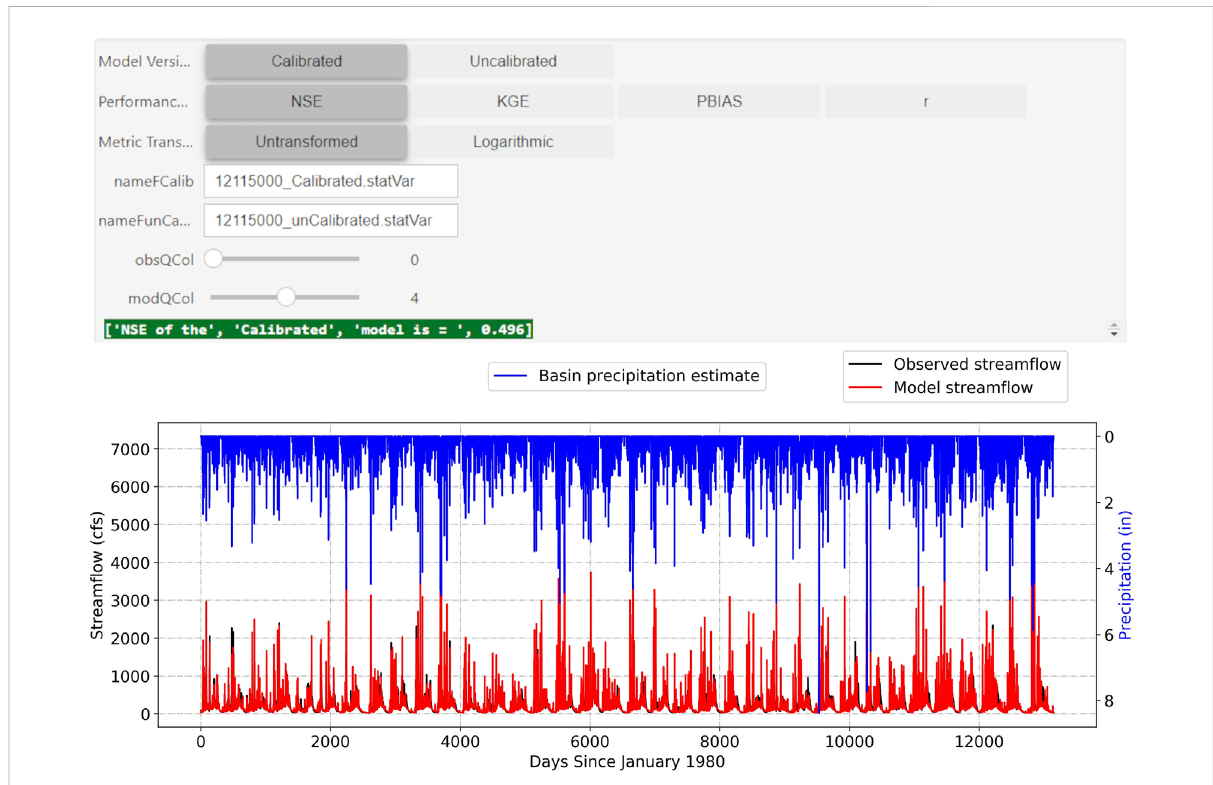
FIGURE 4 Screenshot of HydroBench interactive window showing predictive performance metrics and the corresponding hydrograph for NHM-PRMS simulations of the Cedar River watershed daily stream fl ow, 1980 – 2016, compared to observations (USGS stream gage, 12115000).